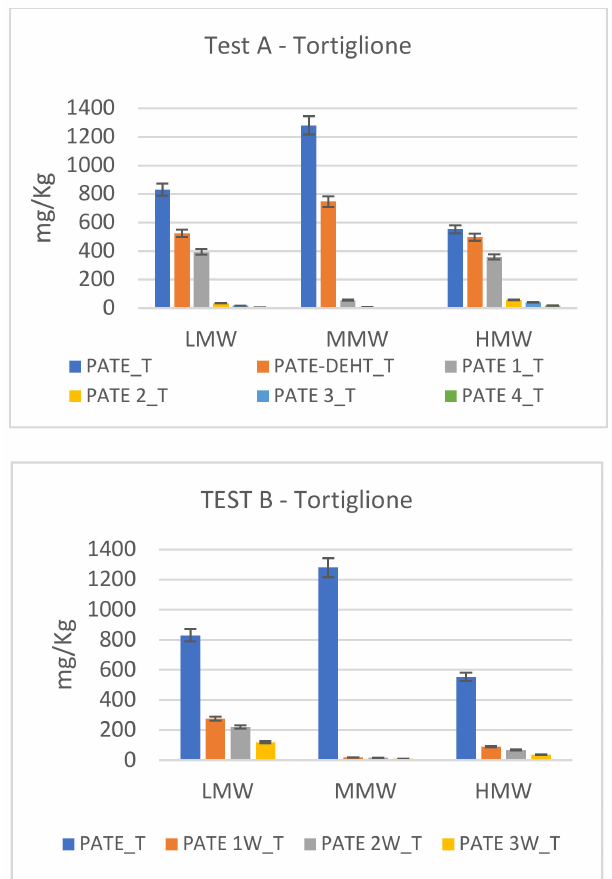
Figure 4. Secoiridoid profile modification in Tortiglione cv. during chemical debittering (Test A) and microbial fermentation (Test B). Data, expressed in mg / kg, are the mean of duplicate analyses and the coe ffi cient of variation is < 5%.